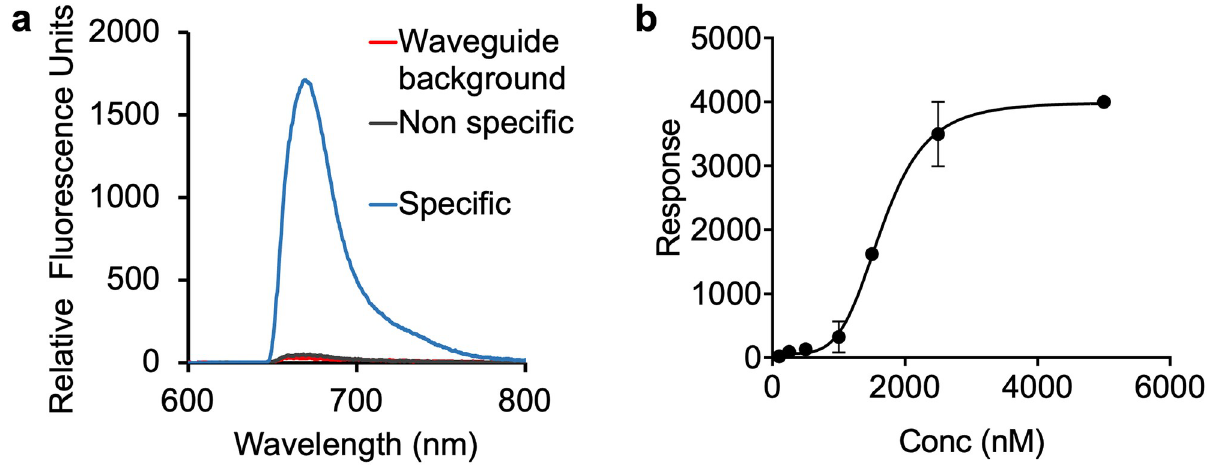
Fig 2. Assay optimization for the detection of LAM in human serum by lipoprotein capture assay. Measurement of LAM by lipoprotein capture assay, as a function of concentration. (a) Representative spectral measurement of LAM (1.5 μ M) incubated overnight at 4 ˚C in control human serum, with the specific signal (relative fluorescence units, RFU) from the detection of α -LAM antibody (15 nM) as a function of emission wavelength (nm). The background and non-specific signals are measured before the addition of LAM. (b) Lipoprotein capture assay was performed for the detection of LAM spiked into control serum at various concentrations and incubated overnight to allow incorporation of the amphiphile into carrier assemblies. Results are plotted as RFU as measured on the waveguide-based optical biosensor, at increasing concentrations of LAM. All values given in (b) are the mean ± standard deviation derived from at least two independent determinations (n = 2). Statistical significance was determined by Welch’s t-test using GraphPad Prism 8.